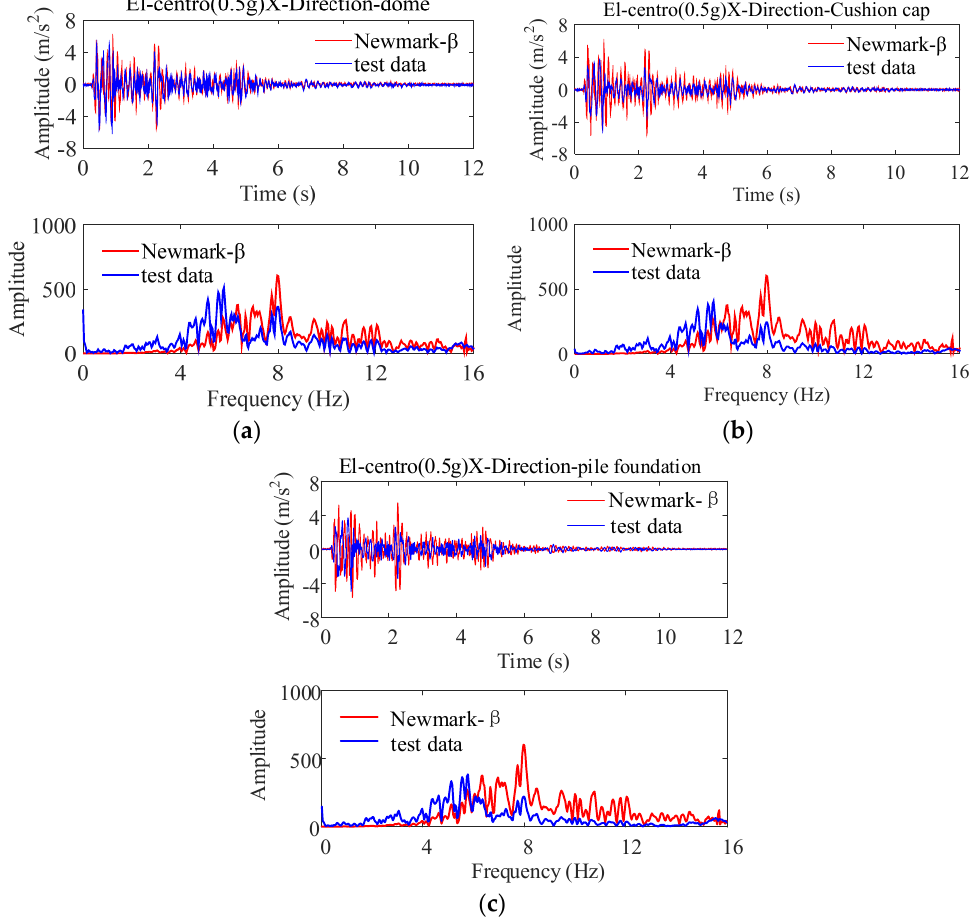
Figure 13. Comparison of shaking table test data and theoretical solutions under the El − Centro wave: ( a ) dome acceleration time history and spectrum comparison; ( b ) cushion cap acceleration time history and spectrum comparison; ( c ) pile foundation acceleration time history and spectrum comparison.